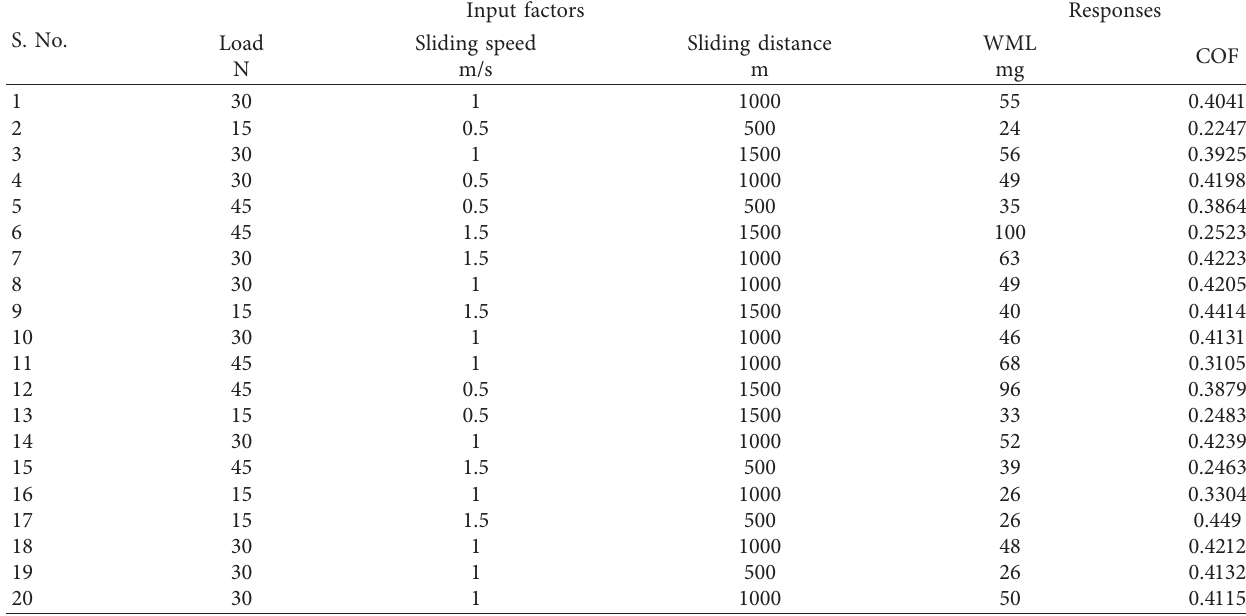
Table 2: Experimental results of wear